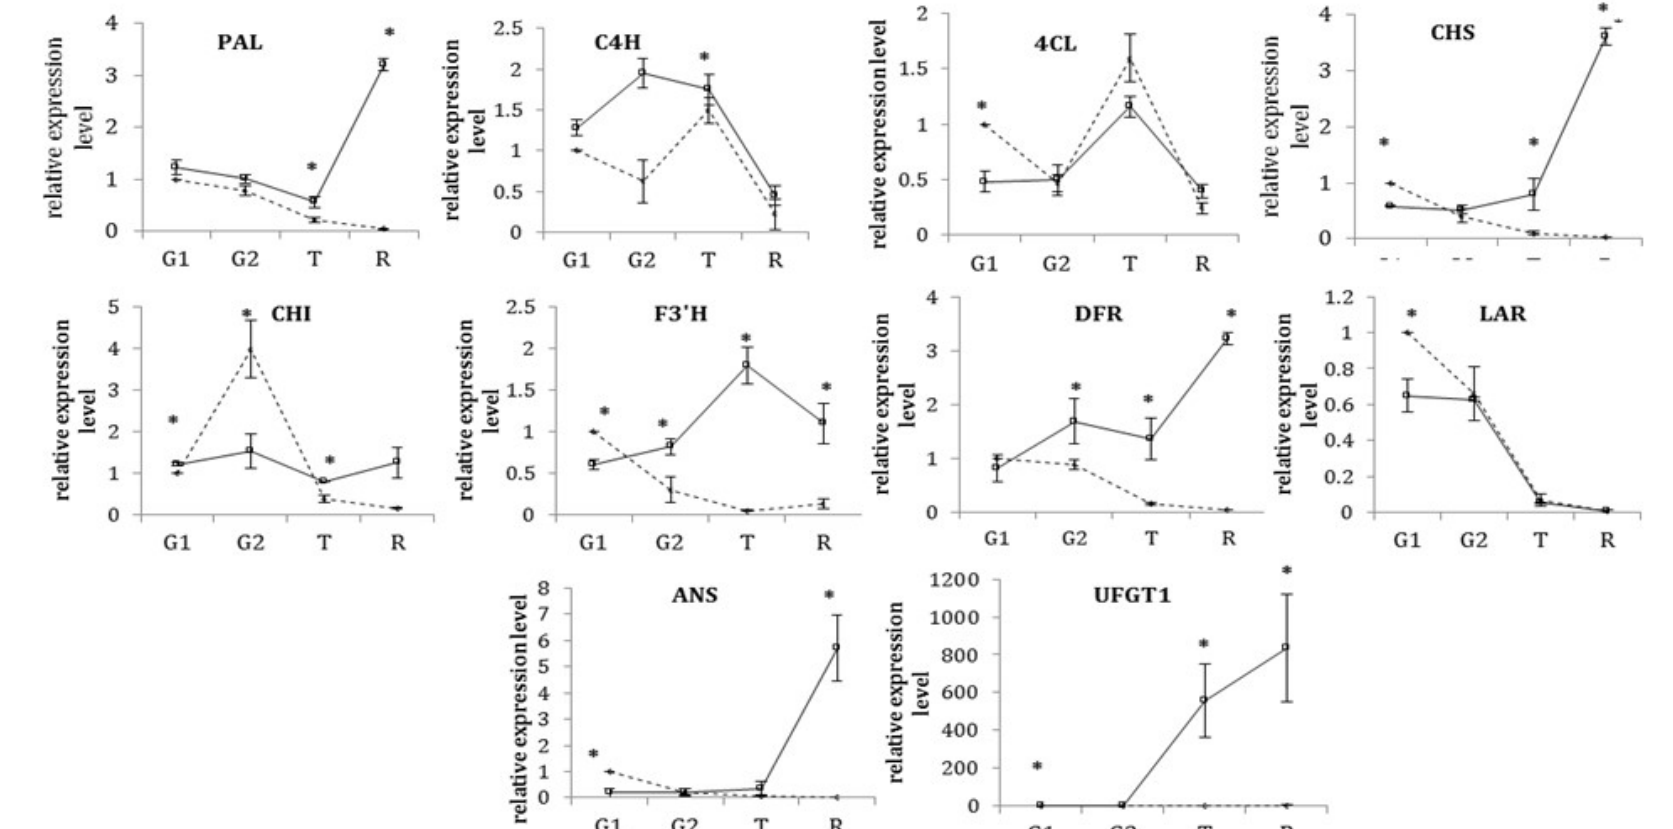
Figure 2. Transcript levels of structural genes involved in the phenylpropanoid/flavonoid biosynthetic pathway during development and ripening of the Fragaria vesca cultivars, Baron Solemacher (solid line) and Pineapple Crush (dashed line) with red and white fruit, respectively. Developmental stages are: G1 = early green with no spacing between achenes, G2 = intermediate green with spacing between achenes and green receptacle exposed, T = turning with the receptacle becoming pinkish-white for BS and white for PC, and R = ripe with a soft red receptacle for BS and soft white receptacle for PC. Data represented are the mean of three individual experiments with error bars indicating ±SD. Asterisks indicate a significant difference as determined by Student’s t -test ( p < 0.05).